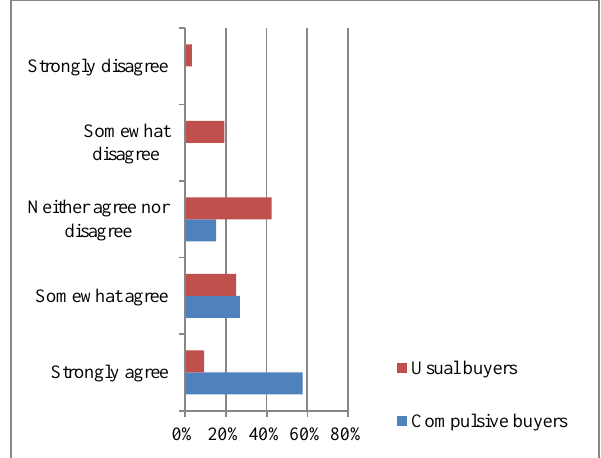
Fig. 3. “Buying things gives me a lot of